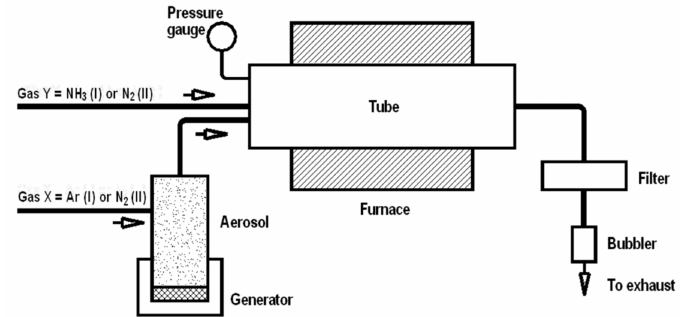
Figure 1. Schematics of experimental set-up for in-flow spray/aerosol pyrolysis of methyltrialkoxysi- lanes under various gas atmospheres. Note, an Ar/NH 3 gas mixture is applied in option I, whereas exclusively N 2 gas is applied in option